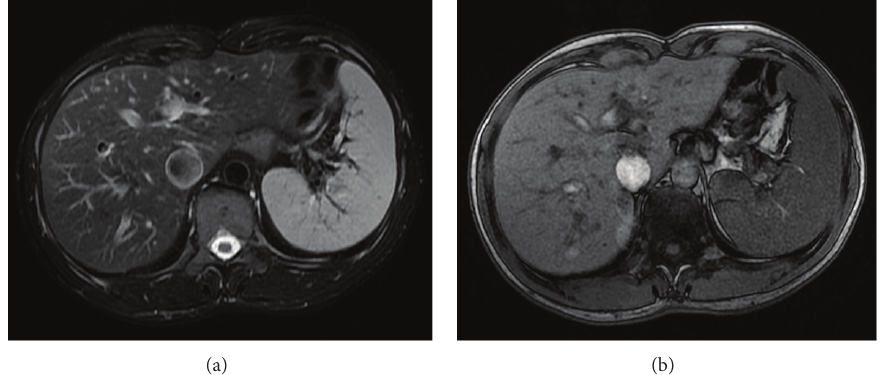
Figure 1: The normal spleen. Axial T2wi FSE with fat suppression (a) and axial T1wi out-of-phase GRE (b). The spleen shows the typical coffee bean configuration. On T1wi (b), the normal signal intensity of the spleen is lower than that of hepatic tissue. Conversely, on T2wi, the spleen shows higher signal intensity.